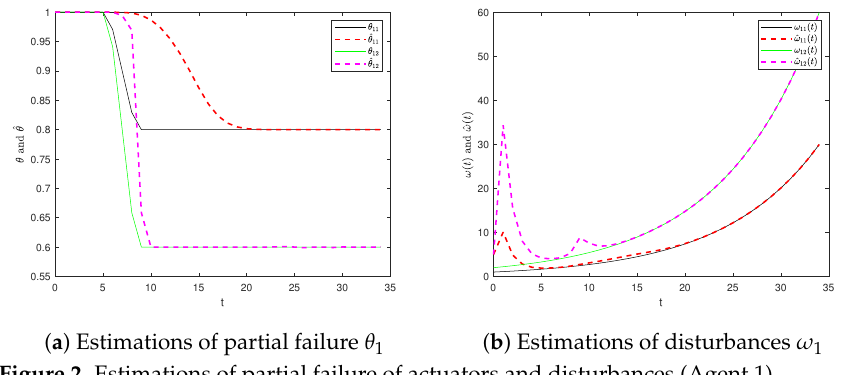
Figure 2. Estimations of partial failure of actuators and disturbances (Agent 1).